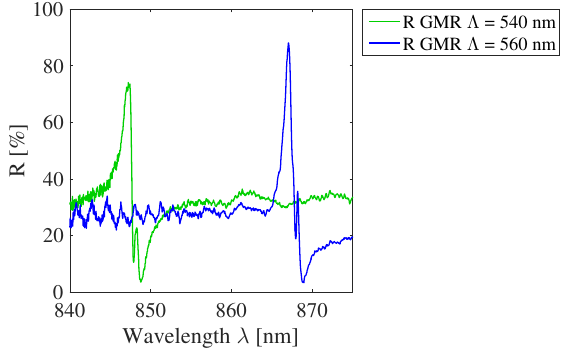
Figure 28. The reflectivity of two OrmoCore GMR grating